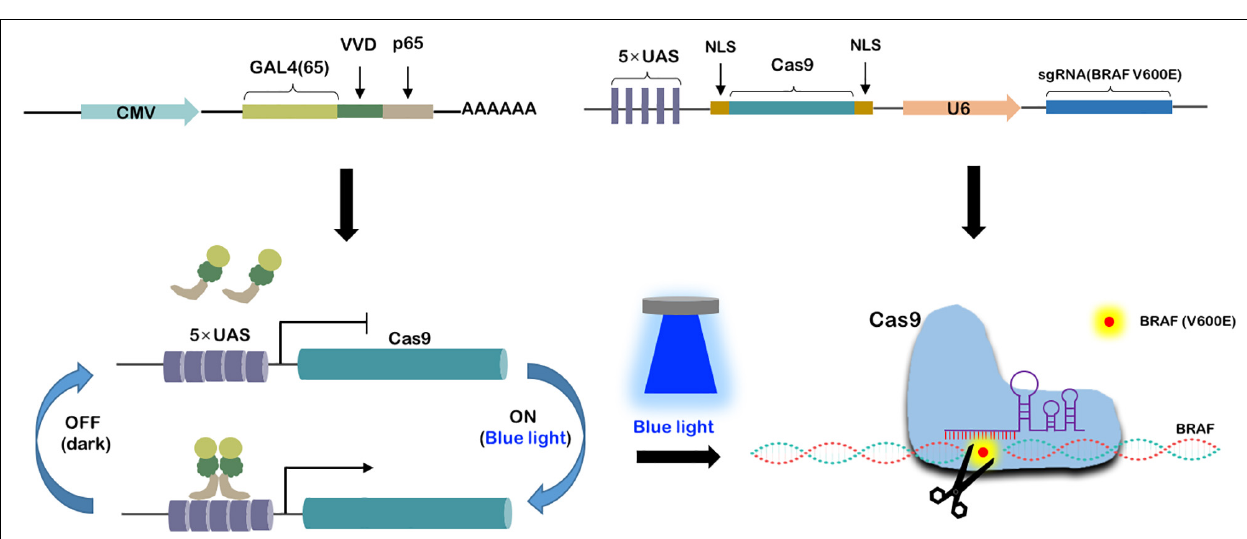
of dark and blue light (0.84 W/m 2 ; 1 s:30 s) conditions, the